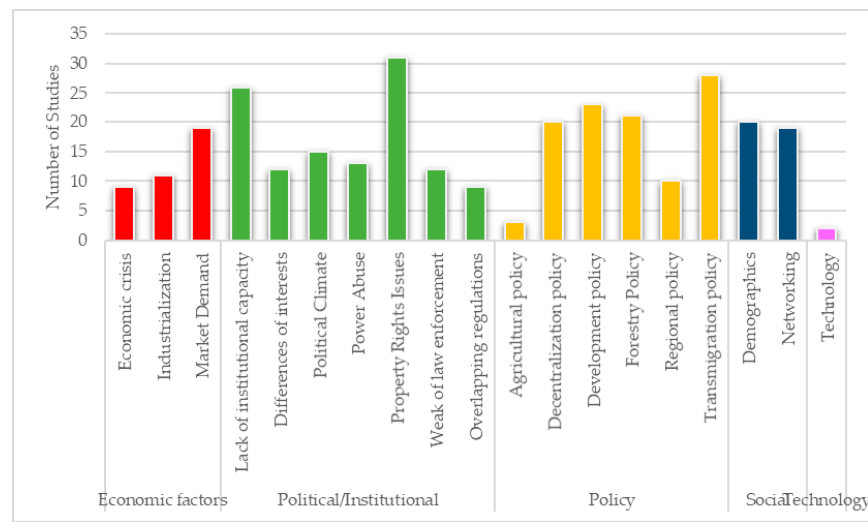
Figure 6. Diagram of underlying causes of land change in Sumatra and Kalimantan.